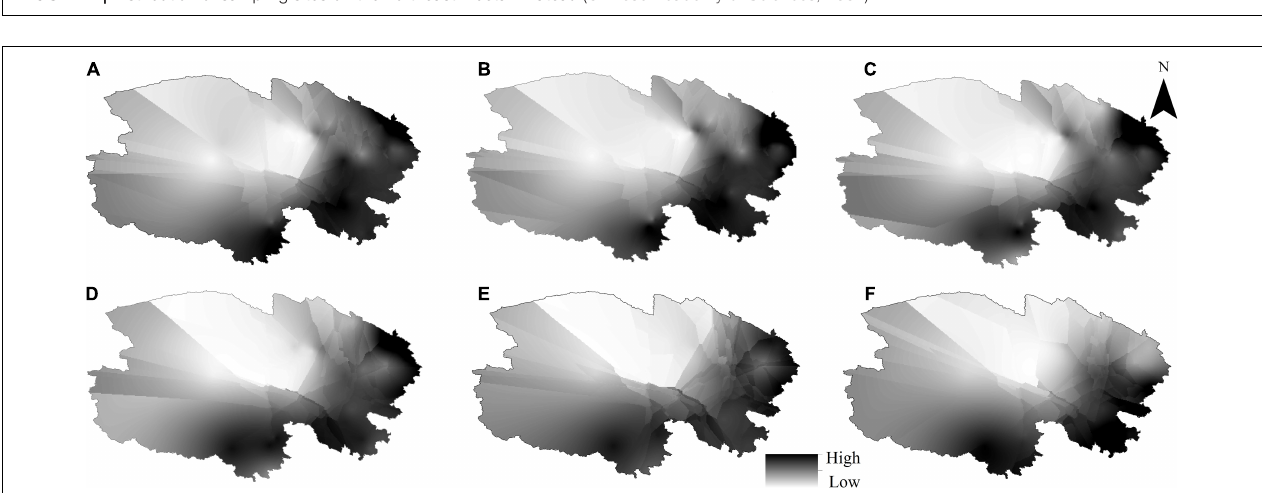
FIGURE 1 | Distribution of sampling sites on the northeast Tibetan Plateau (Chinese Academy of Sciences, 2001).